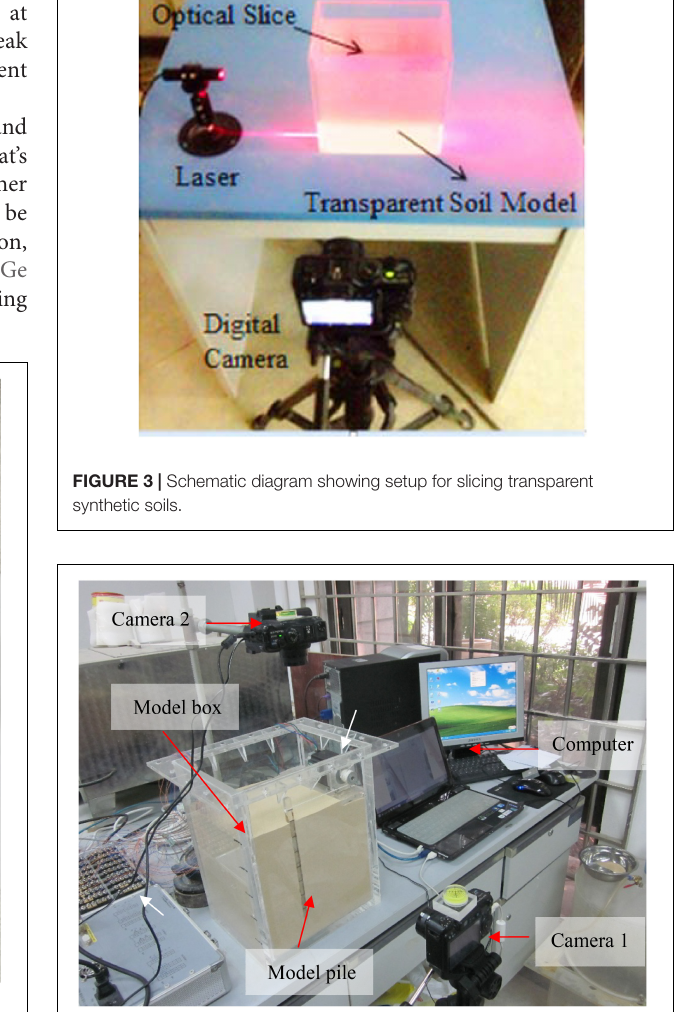
FIGURE 2 | Target viewed through transparent soil model: the words are visible through transparent soil model.